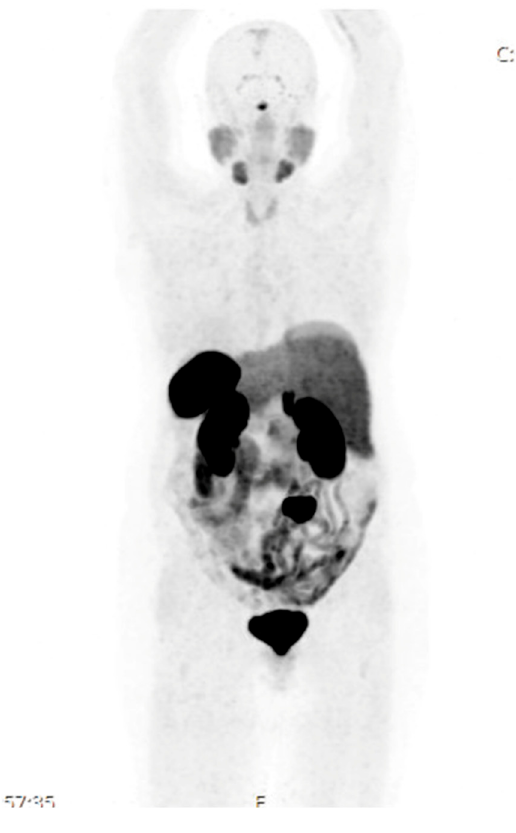
Figure 2. Coronal plane view of the PET Gallium DOTATATE Scan showing DOTATATE uptake of the mesenteric mass 47 × 28 mm.